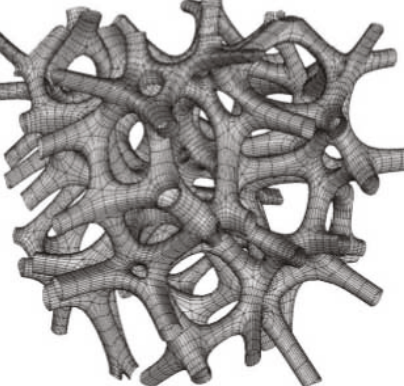
Figure 9: Random cellular structure based on 3D Voronoi tessellation and Catmull-Clark subdivision.